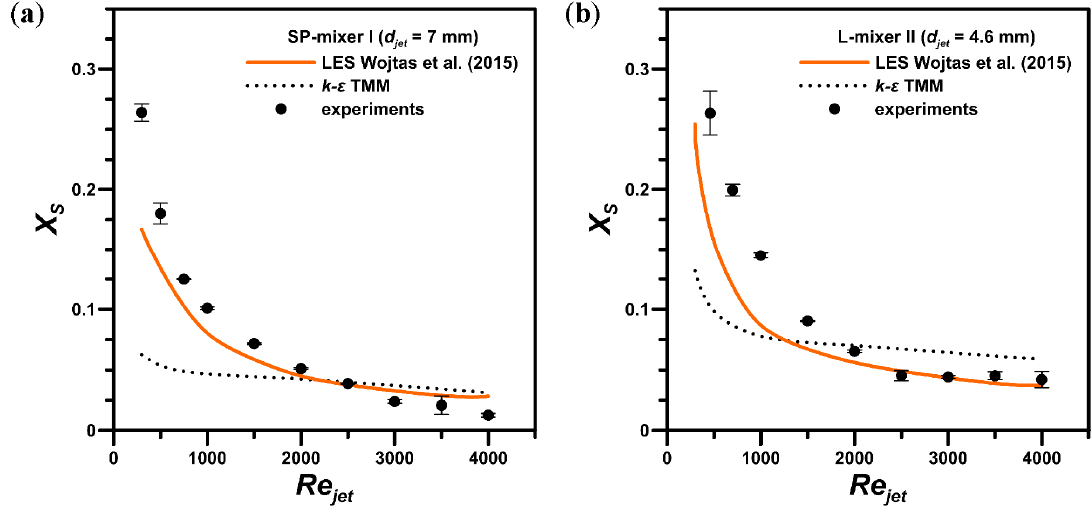
Figure 7. The effect of the jet Reynolds number on the final selectivity of the chemical reaction in: ( a ) SP-mixer I; ( b ) L-mixer II.